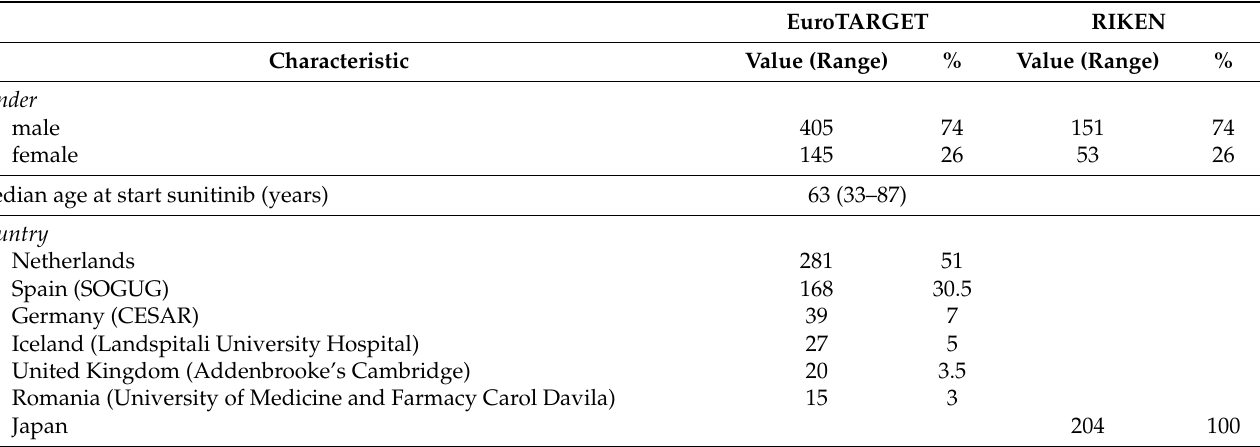
Table 1. Patient characteristics. Patients diagnosed with metastatic renal cell carcinoma, treated with sunitinib, and included for efficacy analyses for EuroTARGET cohort ( n = 550) and Japanese RIKEN cohort ( n =